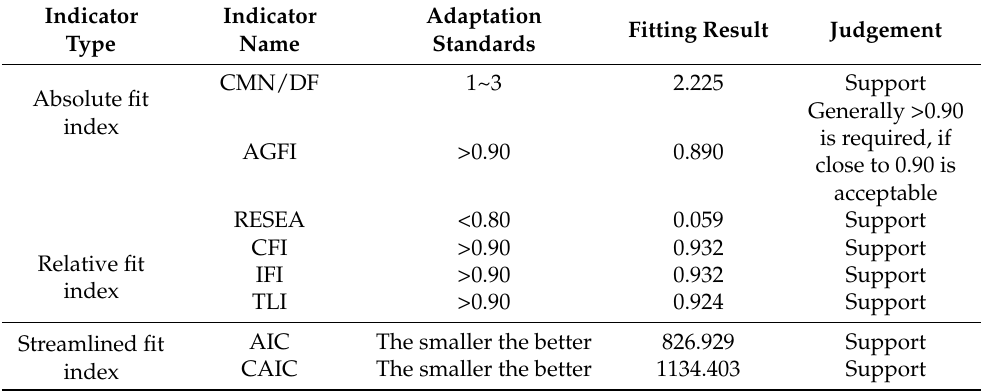
Table 3. Goodness of fit index of